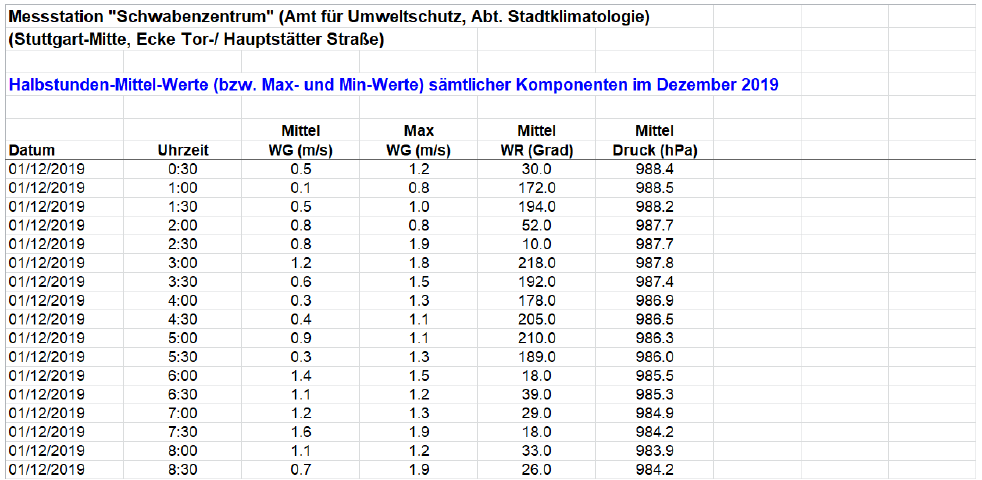
Figure A1. Sample of the historical wind readings for a single